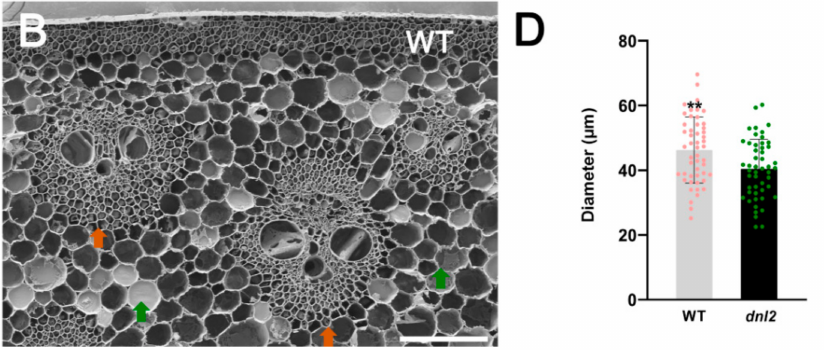
Figure 3. Transverse sections of the seventh internodes at the V15 stage from dnl2 and the wild-type. ( A , B ) Transverse view of the vascular bundles and sclerenchyma cells of dnl2 and the wild-type. ( C ) The area of the vascular bundles of dnl2 and the wild-type. ( D ) The diameter of the parenchymal cells of dnl2 and the wild-type. Orange arrowheads indicate vascular bundles and green arrowheads indicate parenchymal cells. Asterisks indicate significant differences between dnl2 and the wild-type (** p < 0.01). Bars = 150 µ m.